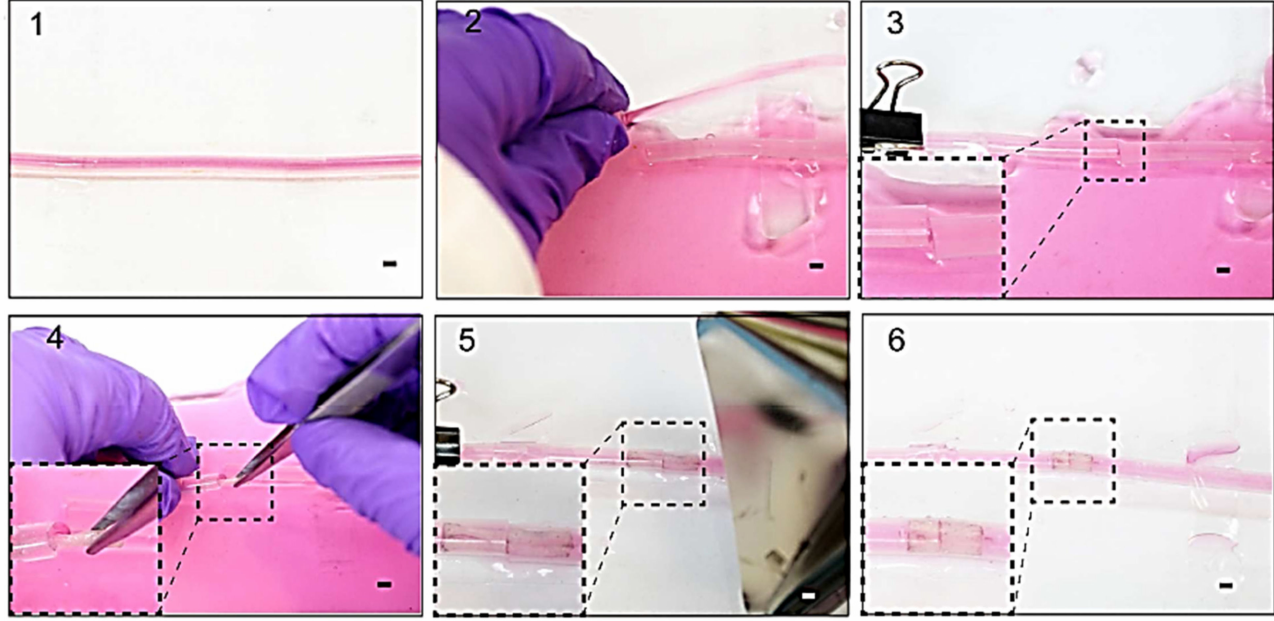
Figure 11. SM tubing for fast vascular reconnection and repair. The blood vessel ( 1 ) was cut for surgery ( 2 ); the severe “bleeding” was temporarily stopped by clamps ( 3 ); the broken “vessel” was implanted with the SM elastomer in the crack position ( 4 ). After being heated, the SM tubing returns to its original shape and is joined to the inside surface of the vessel ( 5 ). The fractured vessel was reconnected, allowing blood to flow ( 6 ). The scale bars are all 2 mm. Copyright 2019 ACS. Reprinted with permission from ref.